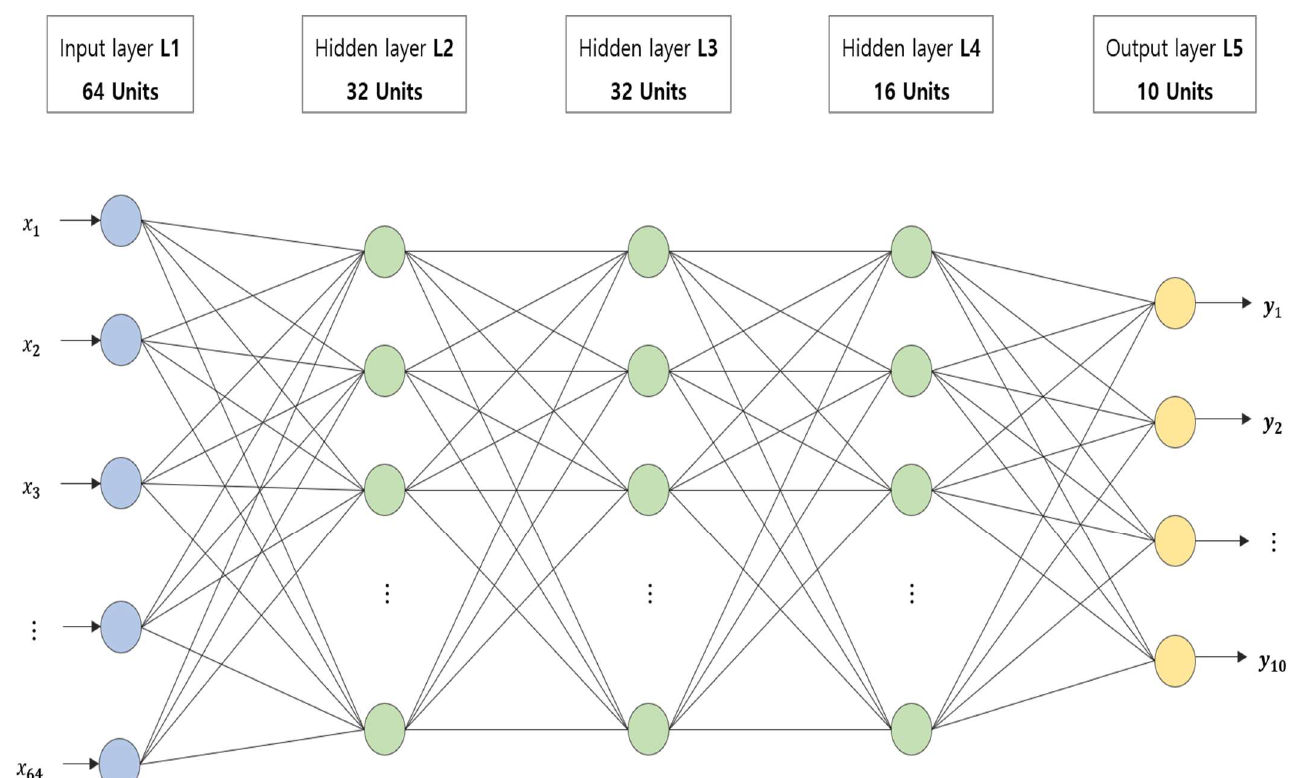
Figure 7. Deep learning model diagram.